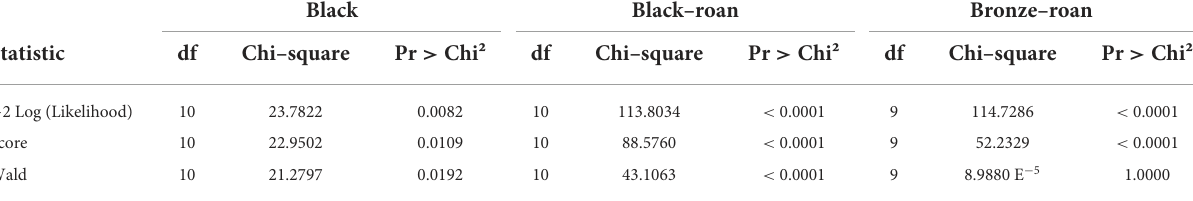
TABLE 3 Test of the null hypothesis (Black: Y = 0.5476, Roan–black: Y = 0.4643, and Roan–bronze: Y =